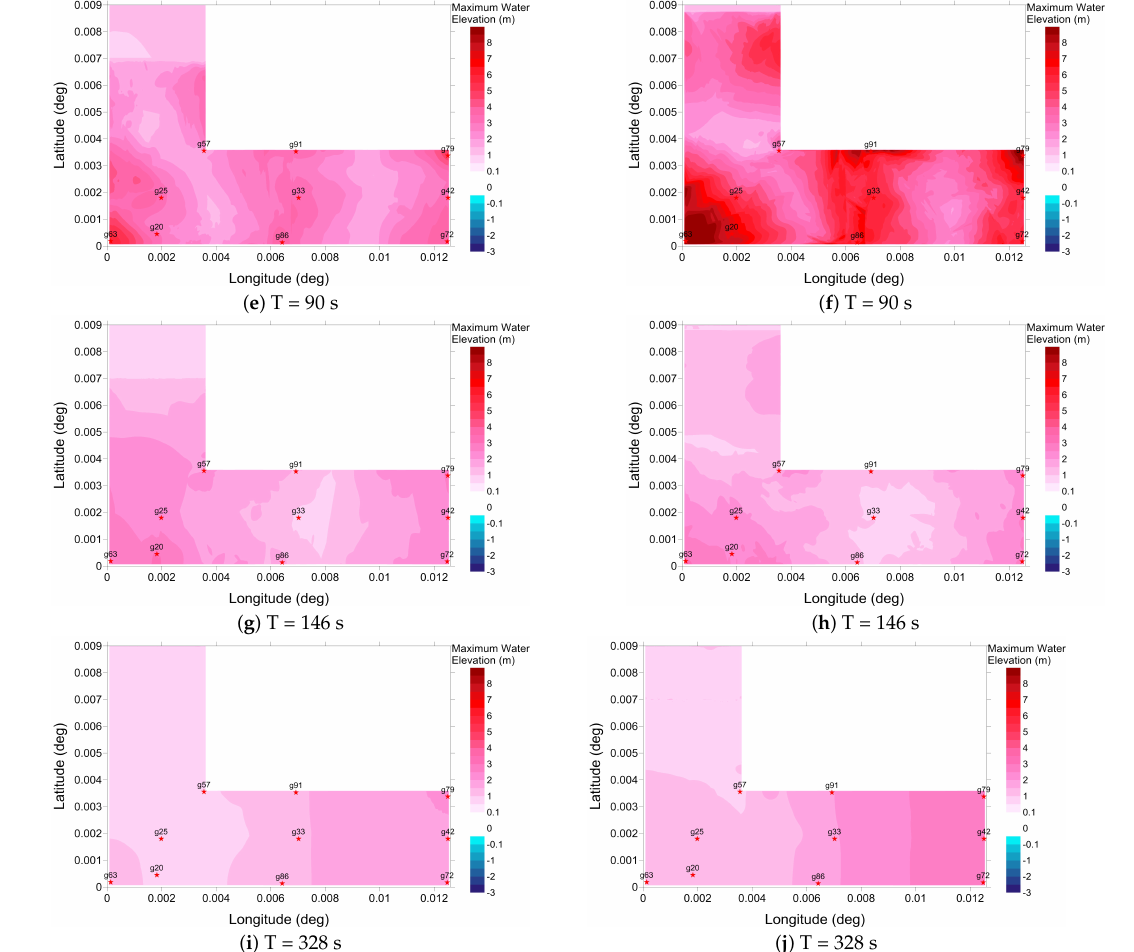
Figure 2. The spatial distribution of the maximum water surface elevation (m) computed by the simulation of the sinusoidal line crest long wave with a 1-m wave amplitude with T = 16 s, T = 46 s, T = 90 s, T = 146 s, T = 328 s for LA/LB = 0.8 in the left column and LA/LB = 1 in the right